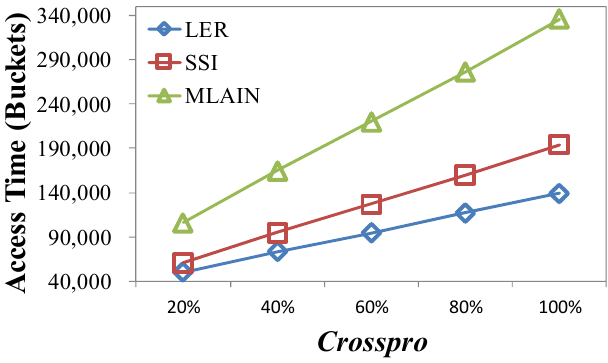
Figure 7. Average access time for changing Crosspro values. Table 2. Average tuning time for changing Crosspro values.